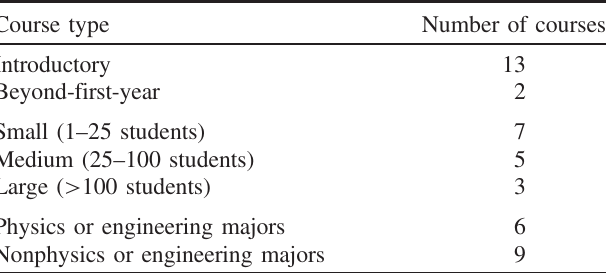
TABLE I. Types of courses that found simulations to be successful.